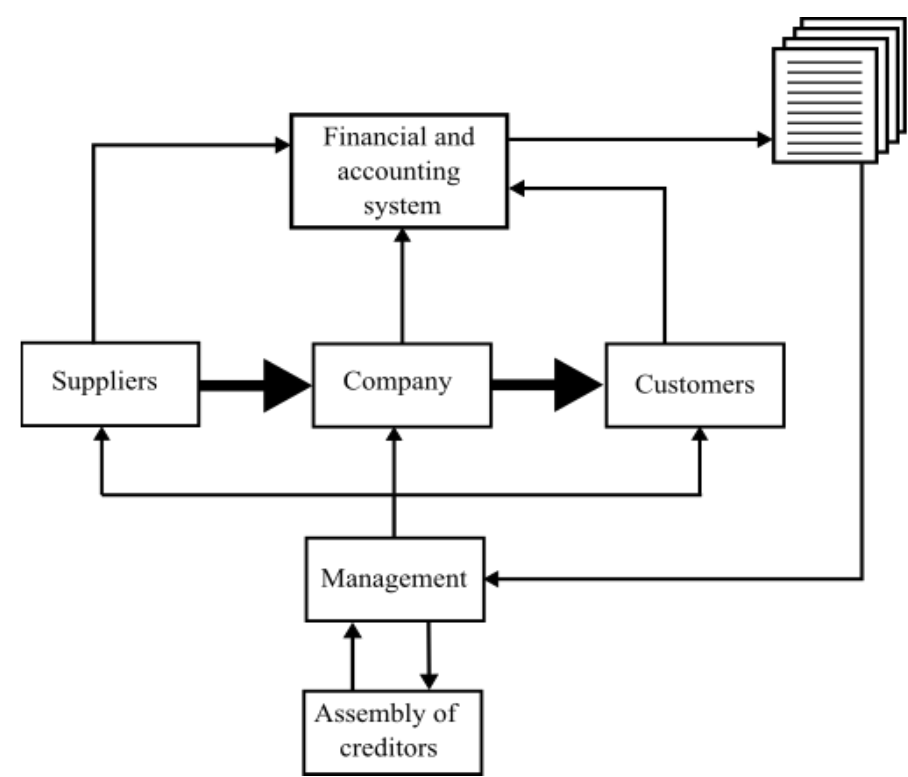
Picture 3. Model of analysis of synthesized financial